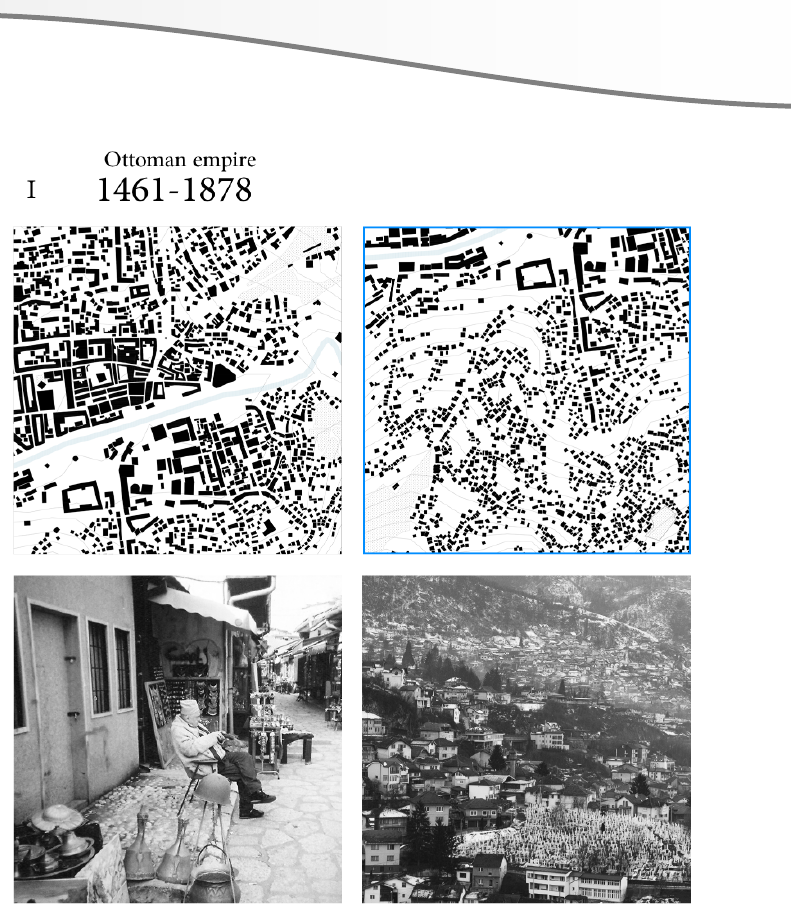
Figure 3: The Stari Grad (old town) in plan and image (left column) and the mahala of Širokača in plan and image (right